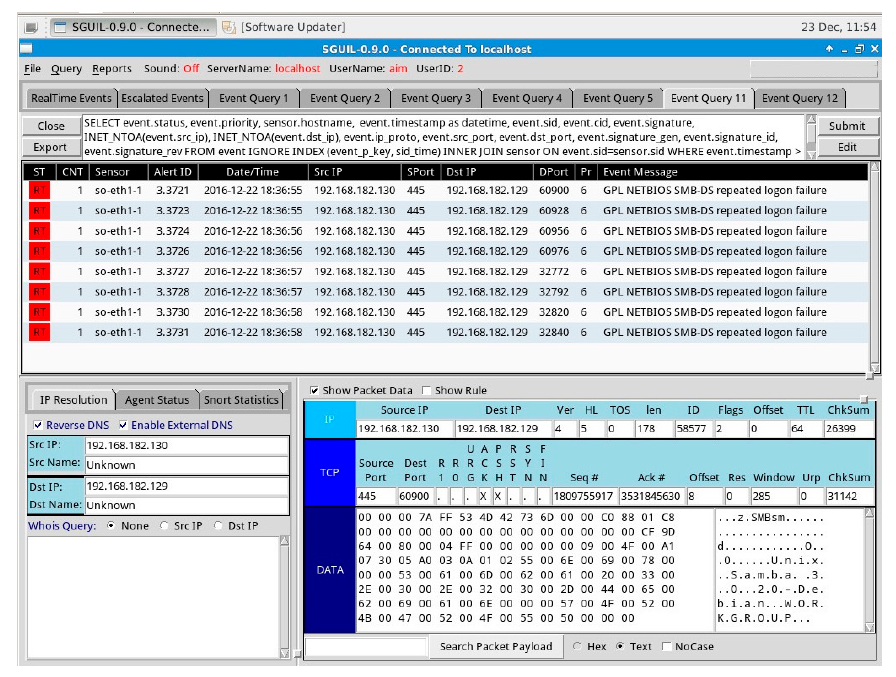
Figure 9. Sguil Console: Samba Attack Alert.